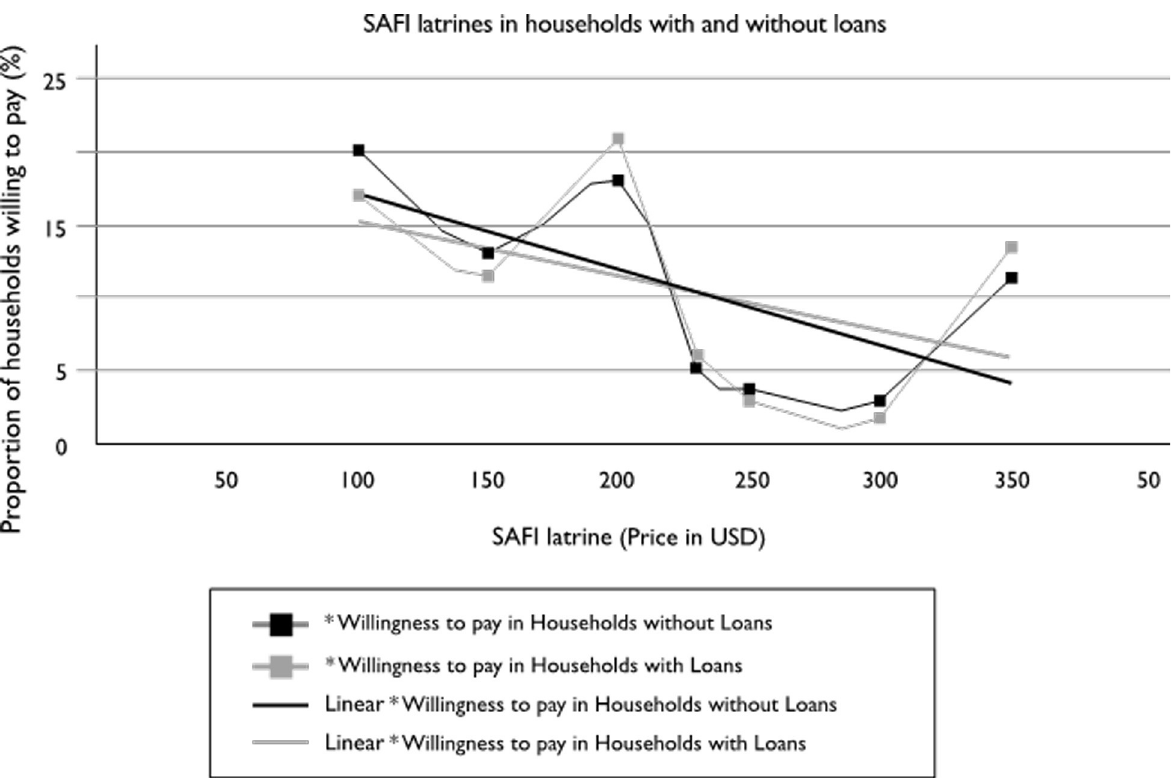
Fig 8. Demand curves for SAFI latrine in households with/without financing.